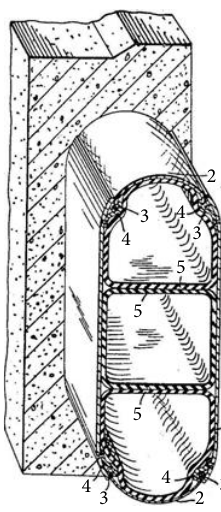
Figure 4: Construction method for hollow lightweight wall ele- ments, invented by Mathews [9].